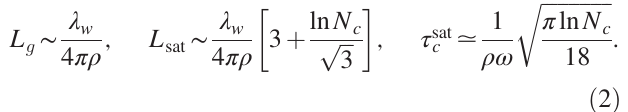
ffiffiffiffiffiffiffiffiffiffiffiffiffi π ln N